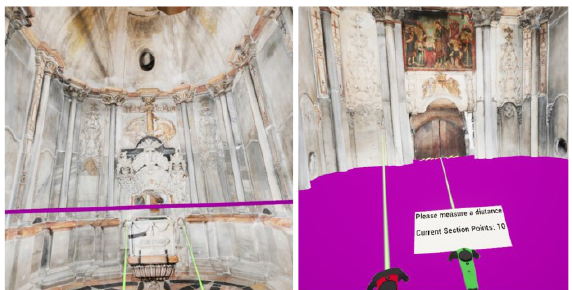
Figure 9 . A horizontal plane of a sectio n of the 3D model’s interior surface